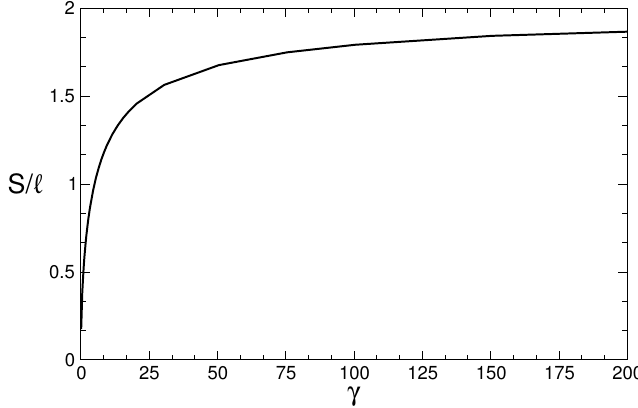
Figure 12: Steady-state entanglement entropy density S /(cid:96) after the quench from the Bose condensate in the repulsive Lieb-Liniger model as function of the interaction strength γ . For infinite repulsion γ → ∞ , the result S /(cid:96) = 2 for hard-core bosons is